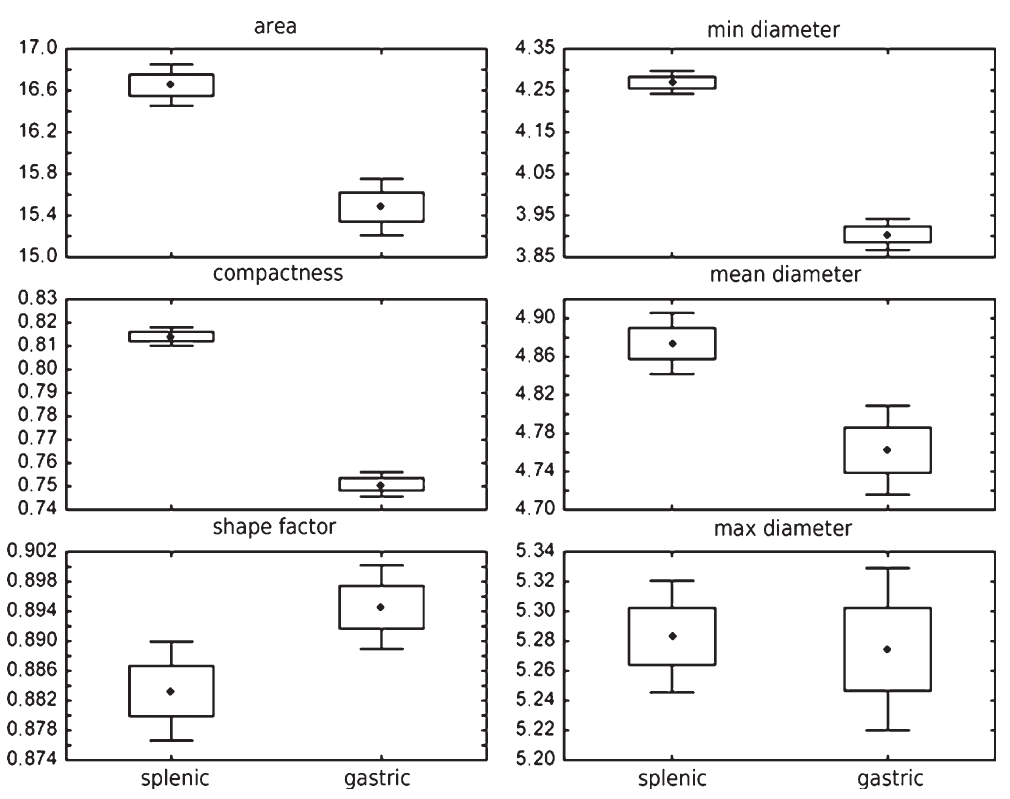
Fig. 2. Basic geometric nuclear parameters. Central point is mean, box indicates mean ± standard error, whiskers mean ± standard